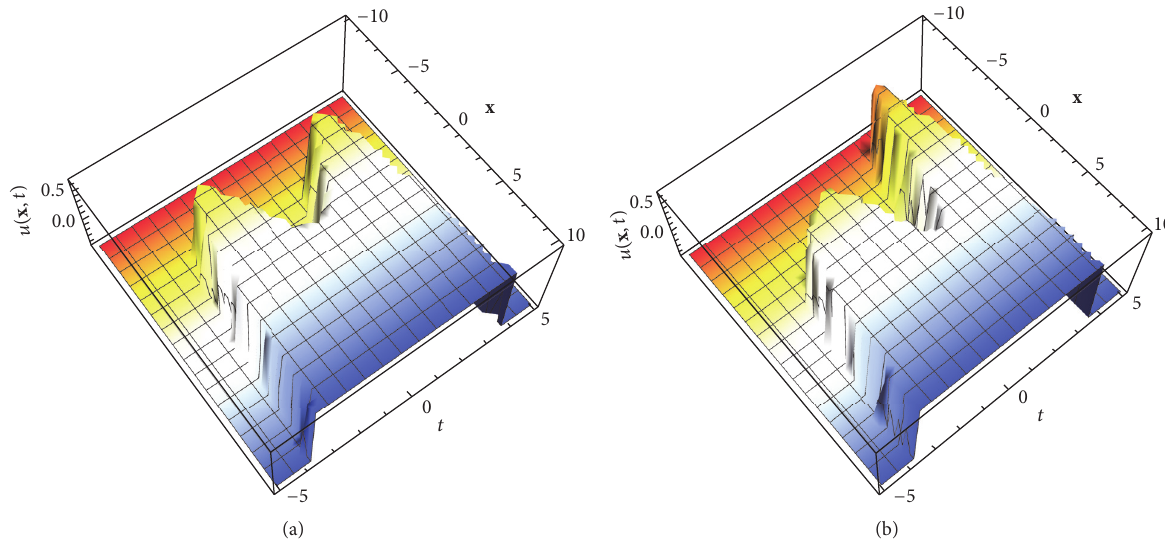
Figure 4: Profiles of the exact solution (40): (a) soliton solution with 𝐵(𝑡) = 0 and (b) solitons solution with 𝐵(𝑡) = 0.5 sin (2𝑡)